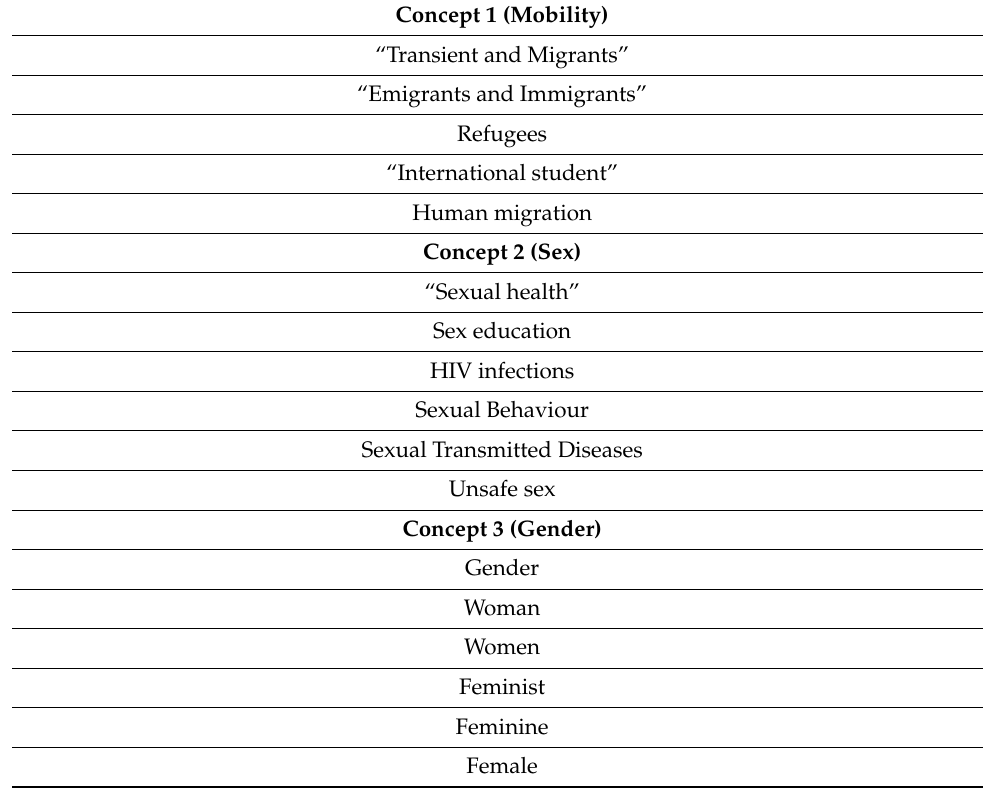
Table 1. Example of search terms used in